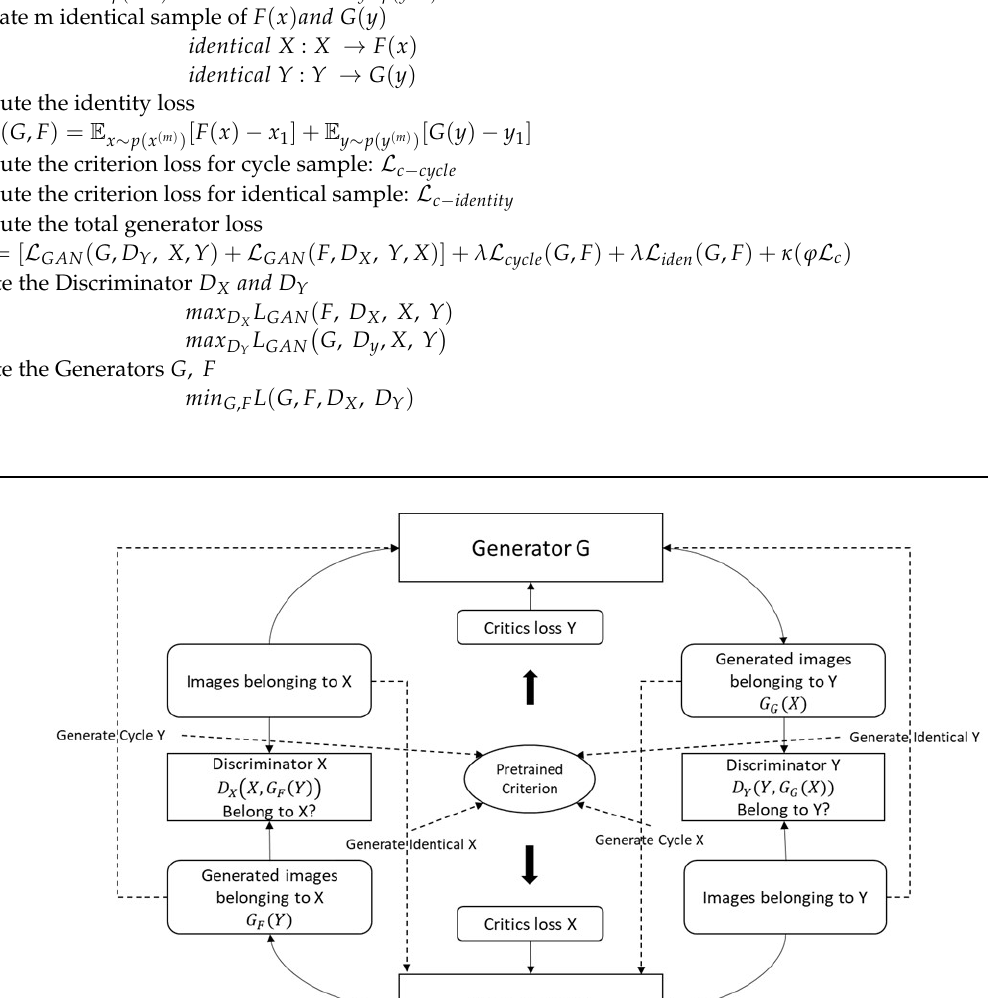
Algorithm 1. Ad CycleGAN Optimization